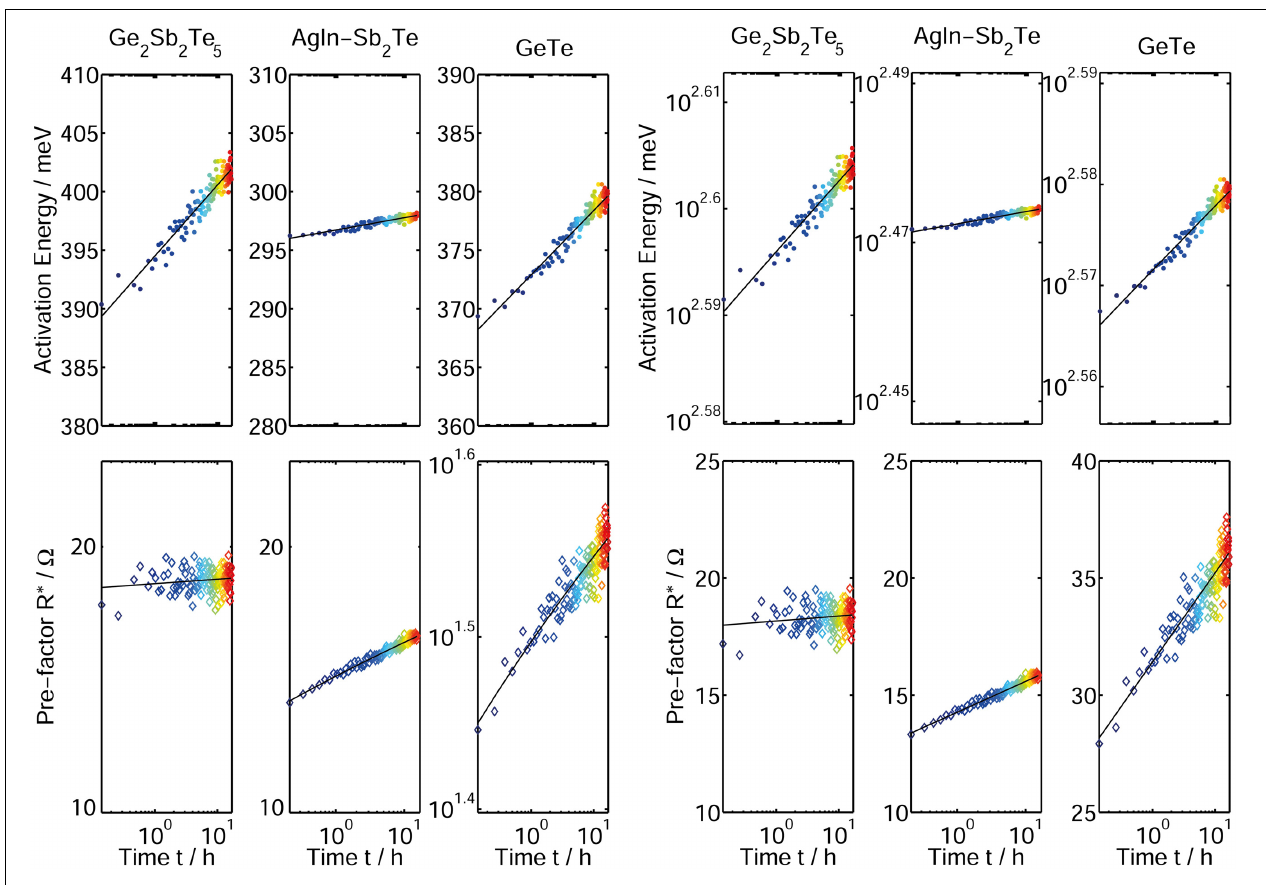
FIGURE 11 | Time-resolved activation energy (top) and Arrhenius prefactor (bottom) plotted on a logarithmic and double logarithmic scale for three phase change materials Ge 2 Sb 2 Te 5 , AgInSb 2 Te, and GeTe. The fits indicated by the black lines are preformed according to E A ( t ) ∼ ln( t ) and ln( R ∗ ( t )) ∼ ln( t ) (Equations 6, 7) (left) and ln( E A ( t )) ∼ ln( t ) and